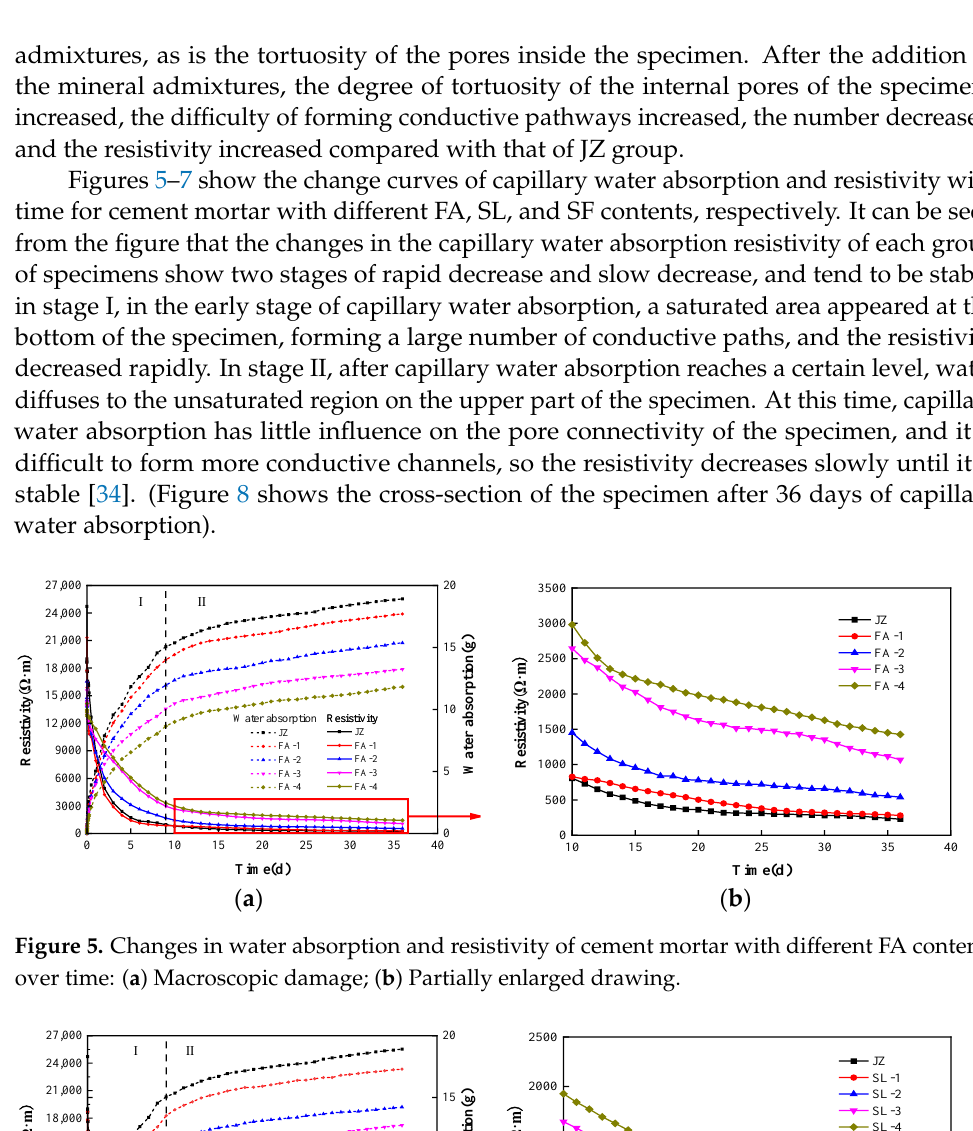
Table 4. Capillary water absorption coefficient fitting equation and parameters.